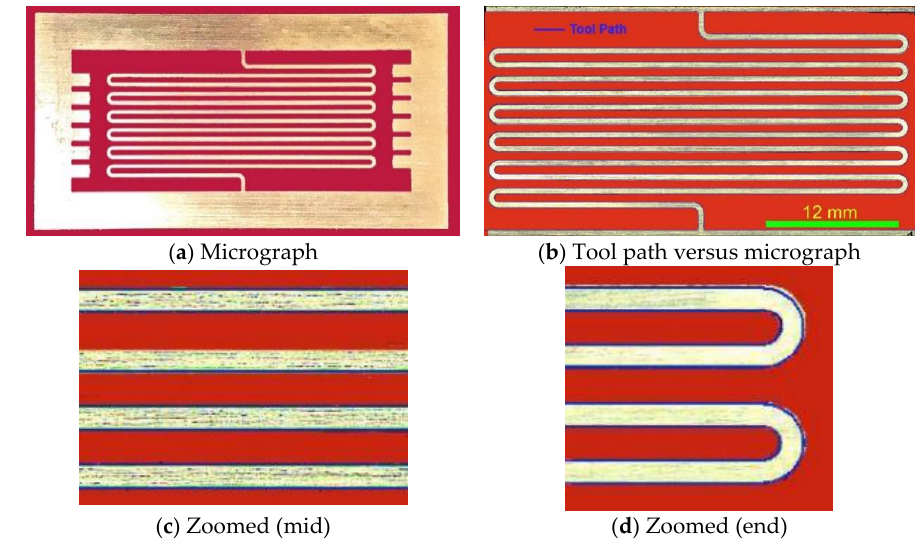
Figure 2. Aluminum flexure - MicroMAX.